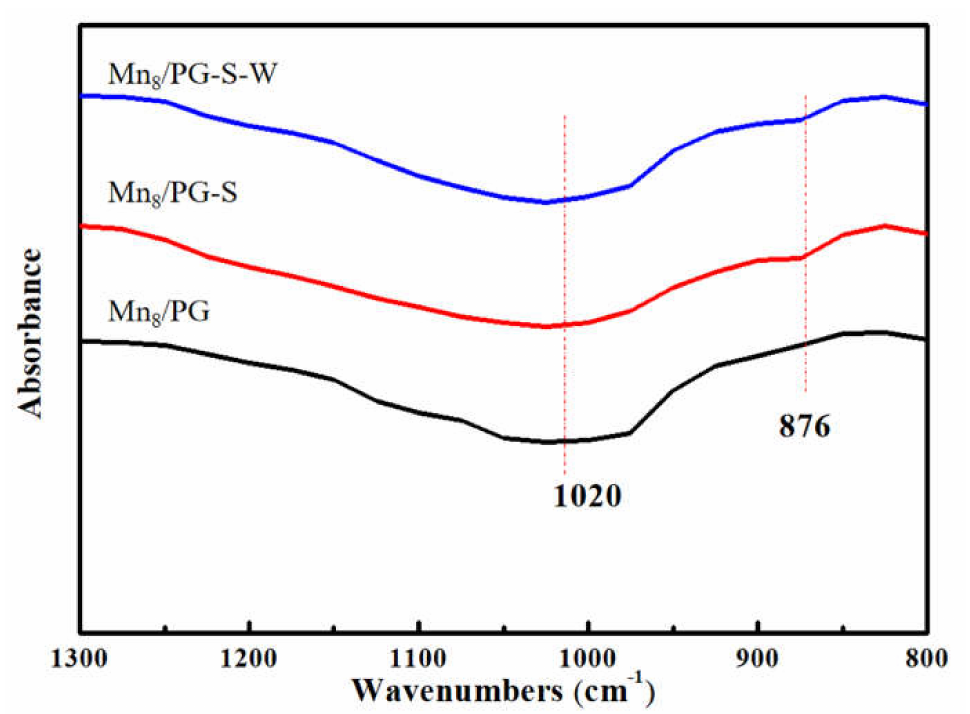
Figure 3. DRIFT spectra of different catalysts.